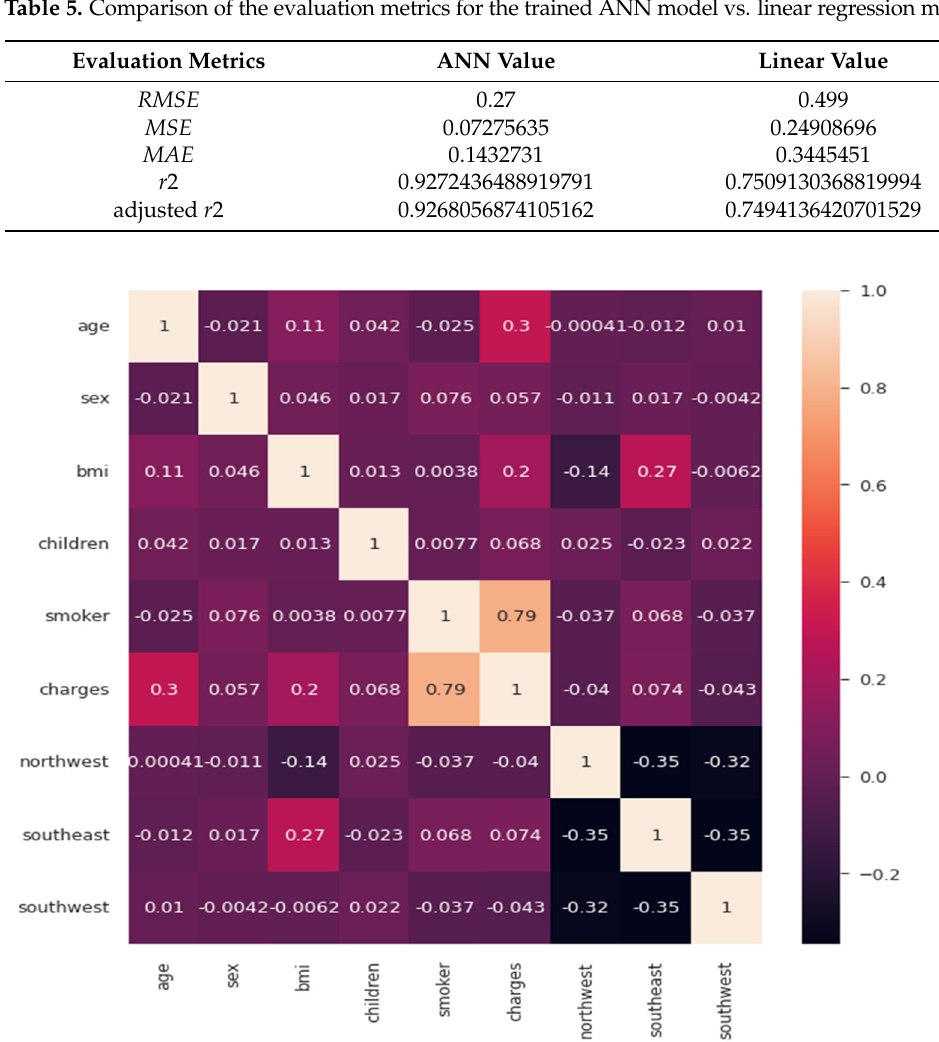
Figure 10. Correlation matrix.